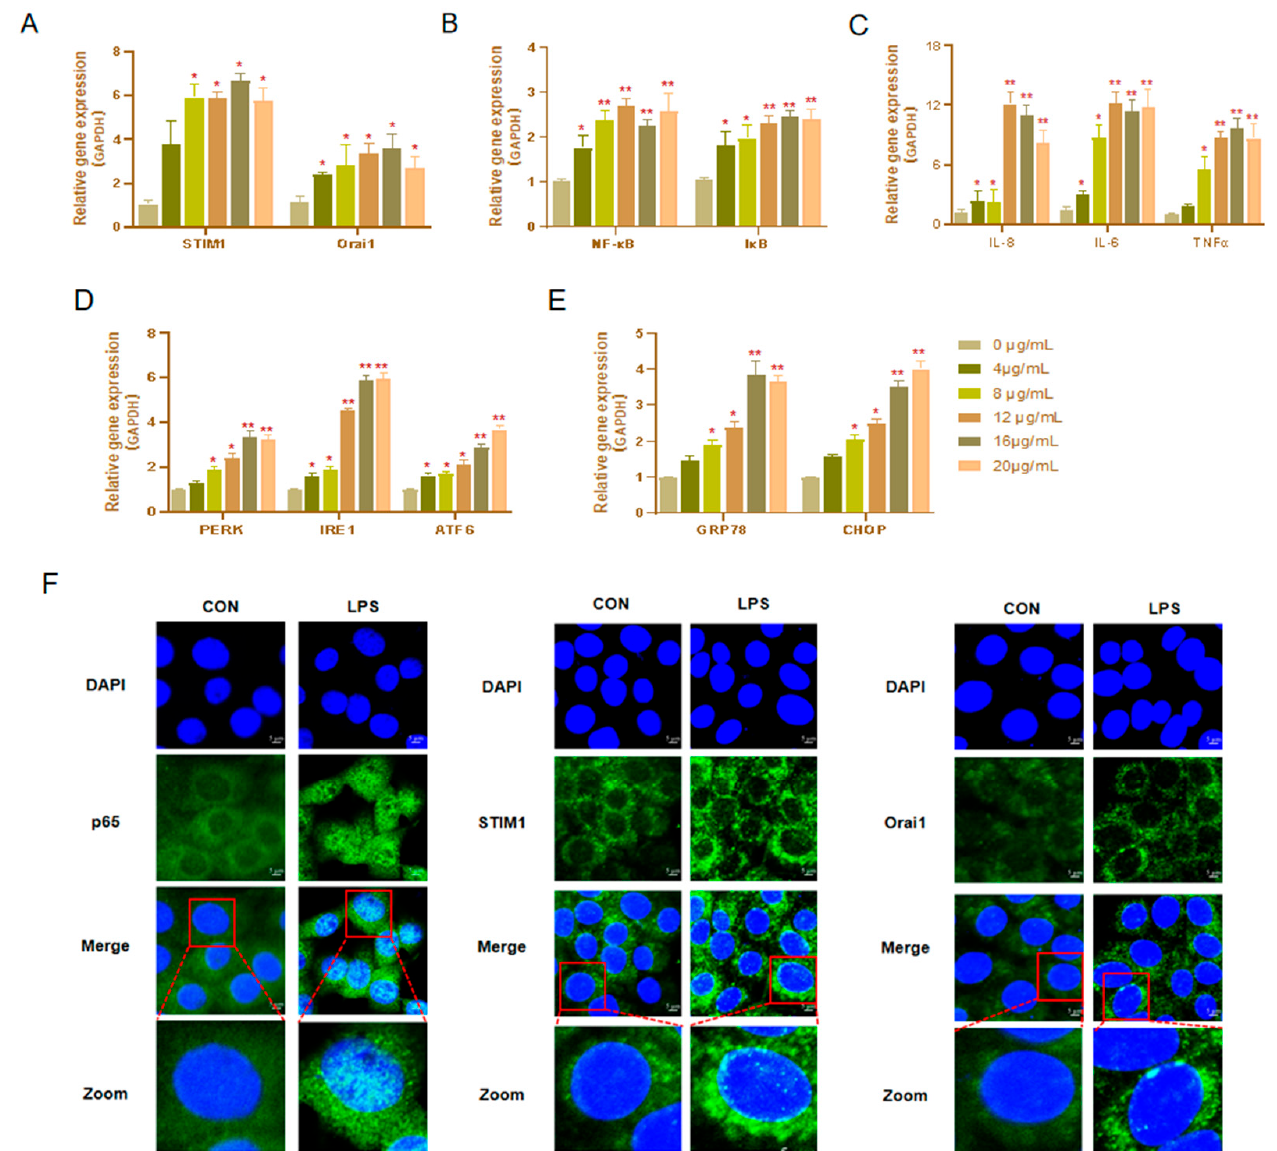
Figure 2. Effects of different concentrations of LPS on bovine hepatocytes (BHEC). When the adherent density of BHEC reached about 70%, the BHEC was treated with LPS at 0, 4, 8, 12, 16, or 20 µ g/mL for 12 h. Gene expression was normalized with GAPDH as the reference protein. ( A ) Gene expression of STIM1 and Orai1 in BHECs. ( B , C ) Gene expression levels of NF- κ B, I κ B, IL-6, IL-8, and TNF- α . ( D , E ) Changes in endoplasmic reticulum stress (ERS)-related genes (PERK, IRE1, ATF6, GRP78, CHOP) under different doses of LPS. Error bars represent the means ± SEM ( n = 3, n = 3). * p < 0.05, ** p < 0.01 compared with the controls. ( F ) After treatment with 16 µ g/mL LPS for 1 h, the fluorescence signals and position changes of STIM1, Orai1, and p65 in BHEC were observed by confocal immunofluorescence microscopy. DAPI blue fluorescence was used to label the location of the nucleus; FITC green fluorescence was used to label the target proteins.